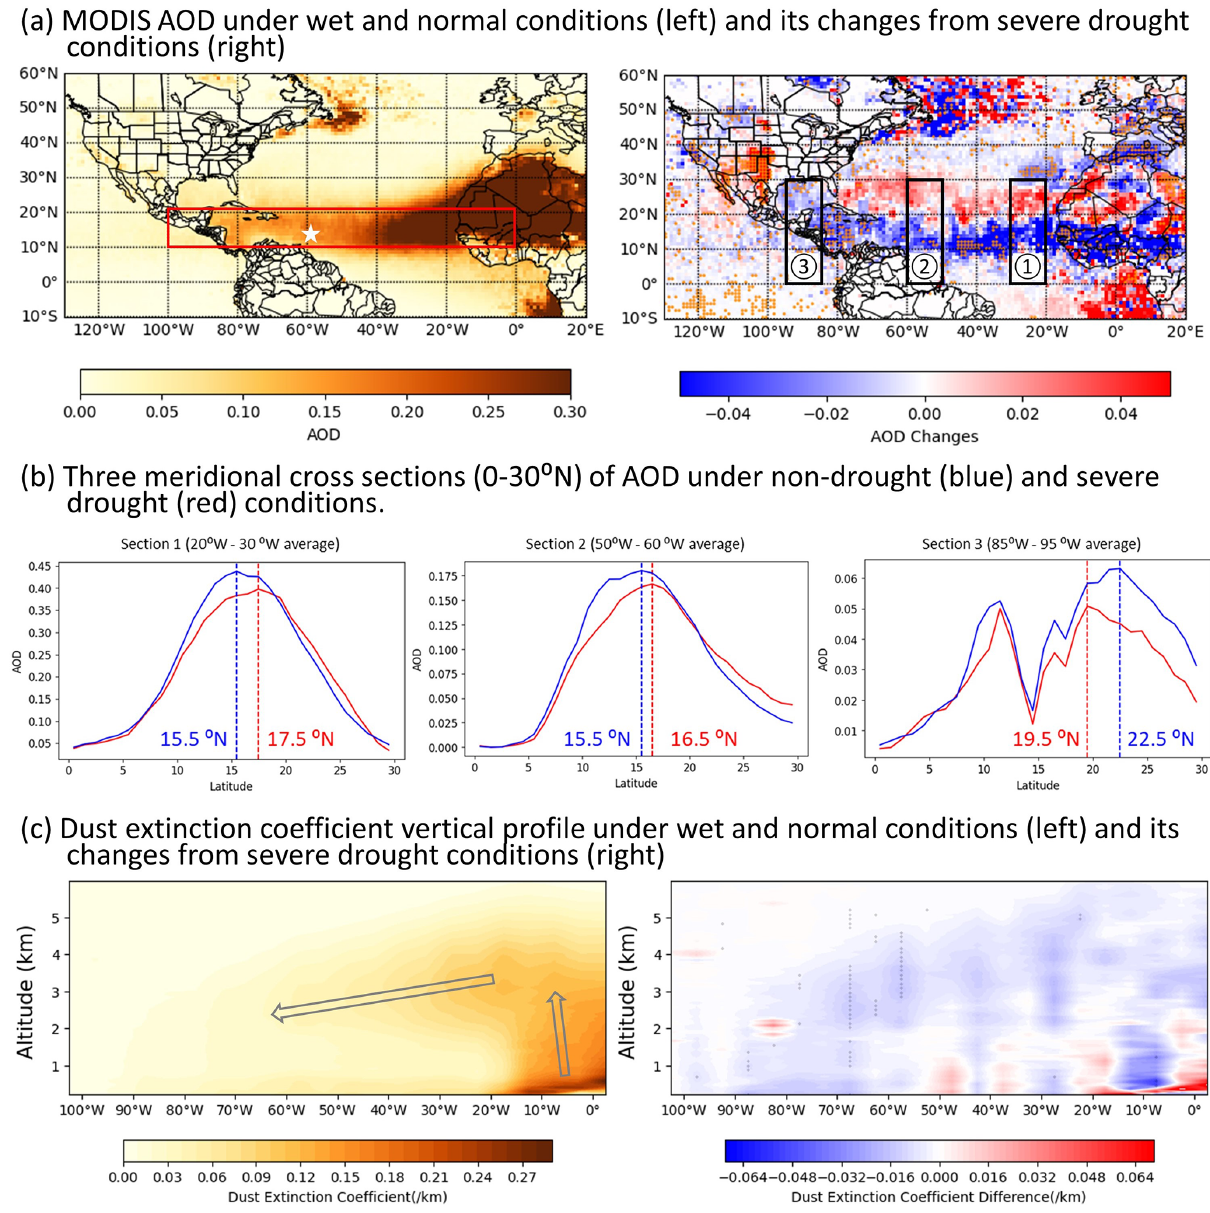
Figure 5. (a) Maps of AOD (550nm) under non-drought (wet and normal) conditions (left column) and its changes during severe droughts (right column). The severe-drought and non-drought periods were chosen based on the weekly time series shown in Fig. 4. The white star denotes the location of the Barbados site (13 ◦ 6 (cid:48) N, 59 ◦ 37 (cid:48) W). Black and red rectangles denote the locations of the cross sections in (b) and (c) , respectively. (b) Meridional cross sections between 0–30 ◦ N averaged near the source region (section 1; 20–30 ◦ W), in the middle of the transport pathway (section 2; 50–60 ◦ W), and over the Gulf of Mexico (section 3; 85–95 ◦ W) under non-drought (blue) and severe-drought (red) conditions. The dashed lines and associated numbers indicate the latitudes with the maximum values of AOD. These three sections correspond to the black rectangles labeled in the right panel of 5a to show their locations. (c) Mean vertical profiles of the dust extinction coefficient during non-drought (left) and severe-drought (right) periods across the major transport pathway (red rectangle in a ). The severe- drought and non-drought periods were chosen based on monthly SPEI between 2006 and 2018. Black or orange dots in (a) and (c) (right column) indicate the significant difference at a 95% confidence level relative to non-drought